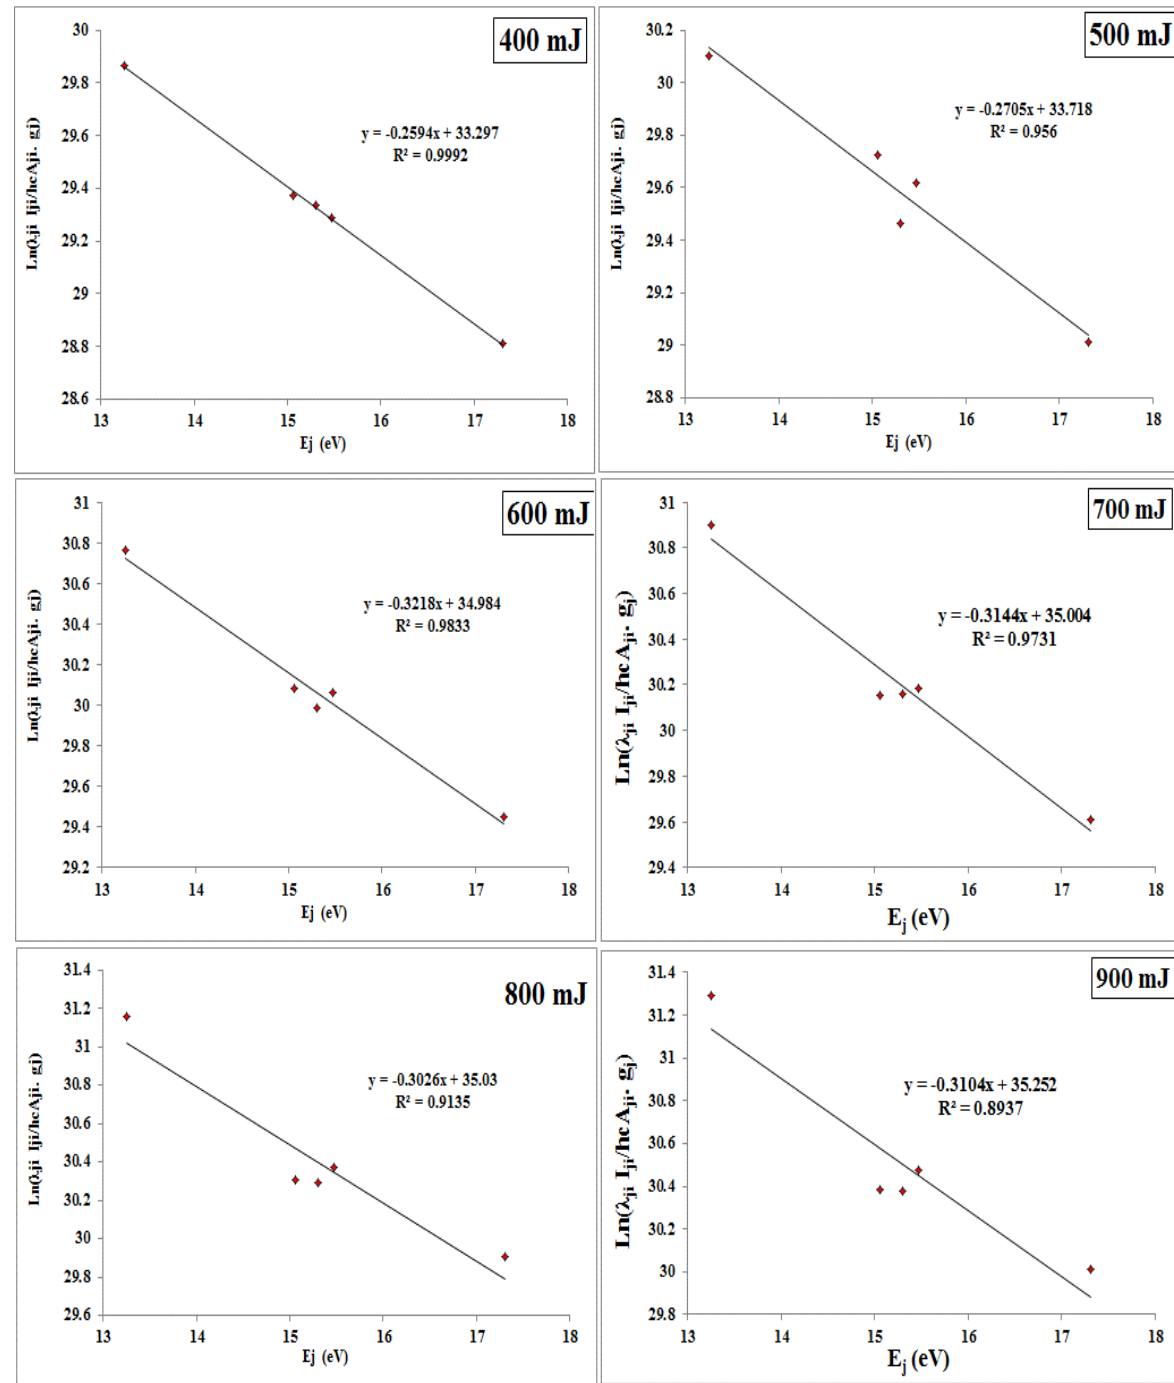
Fig.7: Boltzmann plot method for magnesium and aluminum mix using 1064 nm laser, with different laser